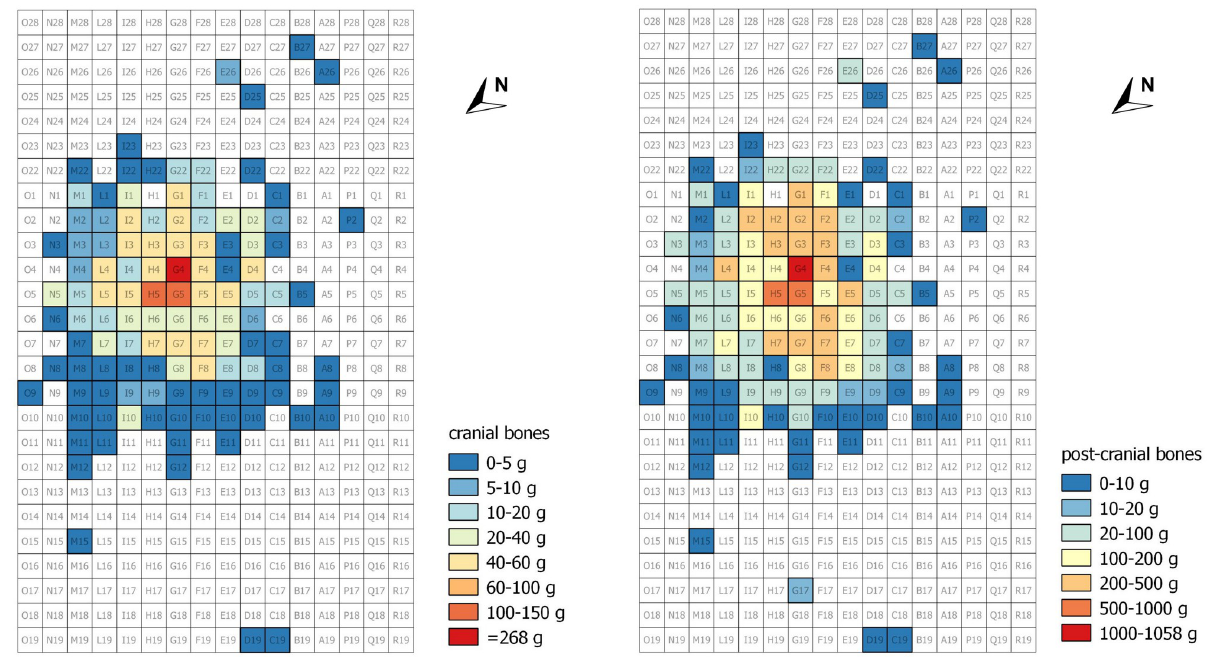
Fig 8. Distribution of cranial (left) and post-cranial (right) fragments in the Salorno—Dos de la Forca ustrinum